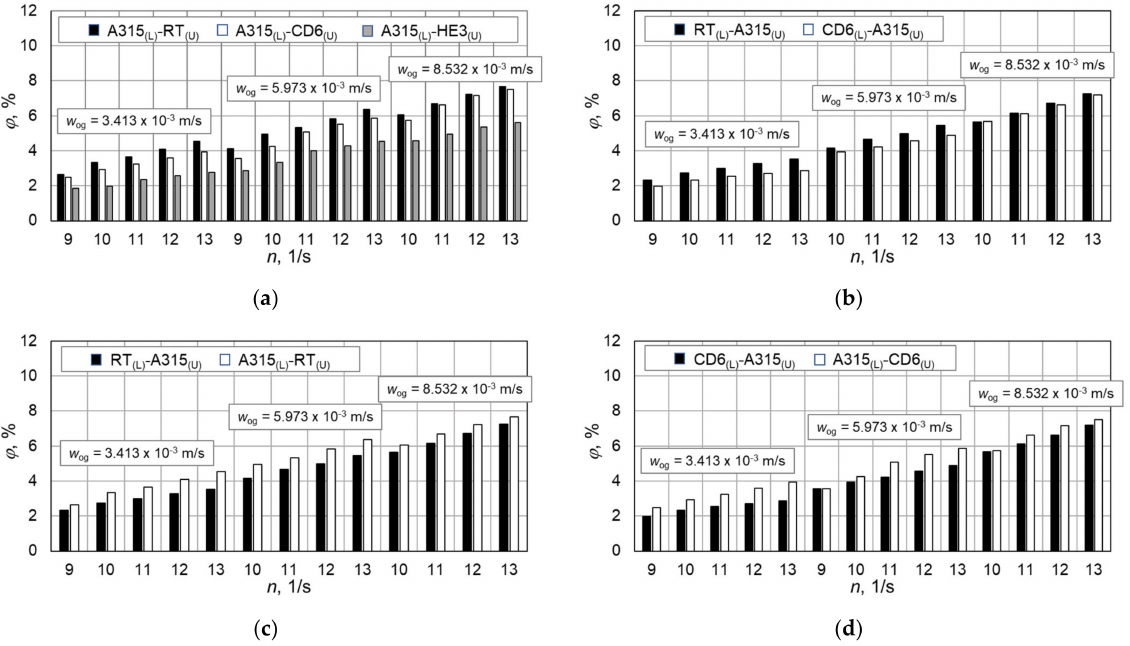
Figure 3. Dependence of ϕ = f( n ) for different configurations of impeller; standard planer baffles, c = 2.5% mass. ( a ) the effect of the upper impeller type; ( b ) the effect of the lower impeller type; ( c , d ) the effect of replacement of two impellers on the shaft.